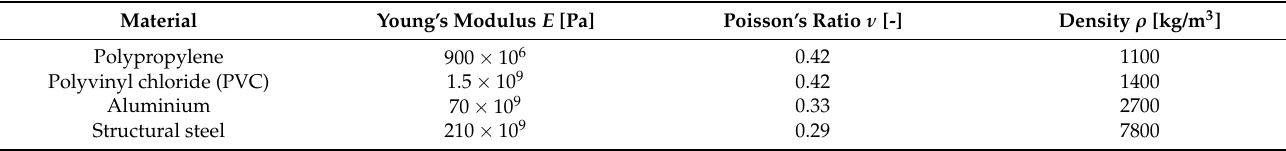
Table 5. Properties of materials used for structural